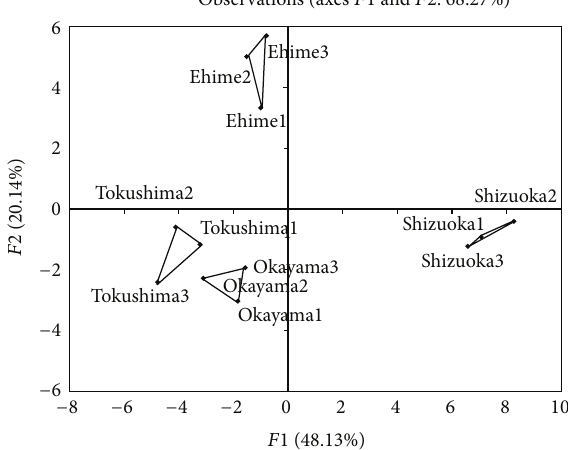
Figure 5: Scoring plots of nontargeted profiling of green algae samples of different origin by GC-MS-SPME. The profiling was carried out based on 41 peaks and detected corresponding peak area ratios. Samples were independently analyzed in triplicate. The data were analyzed by PCA using XL-STAT